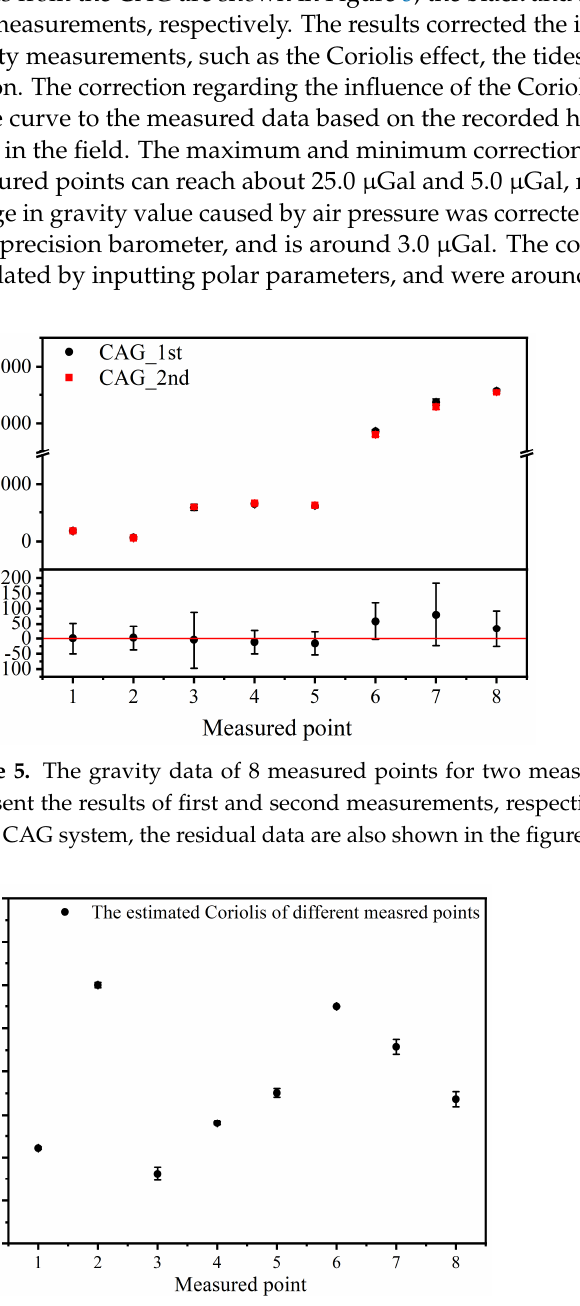
Figure 6. The corrected gravity of different measured points due to Coriolis effect.